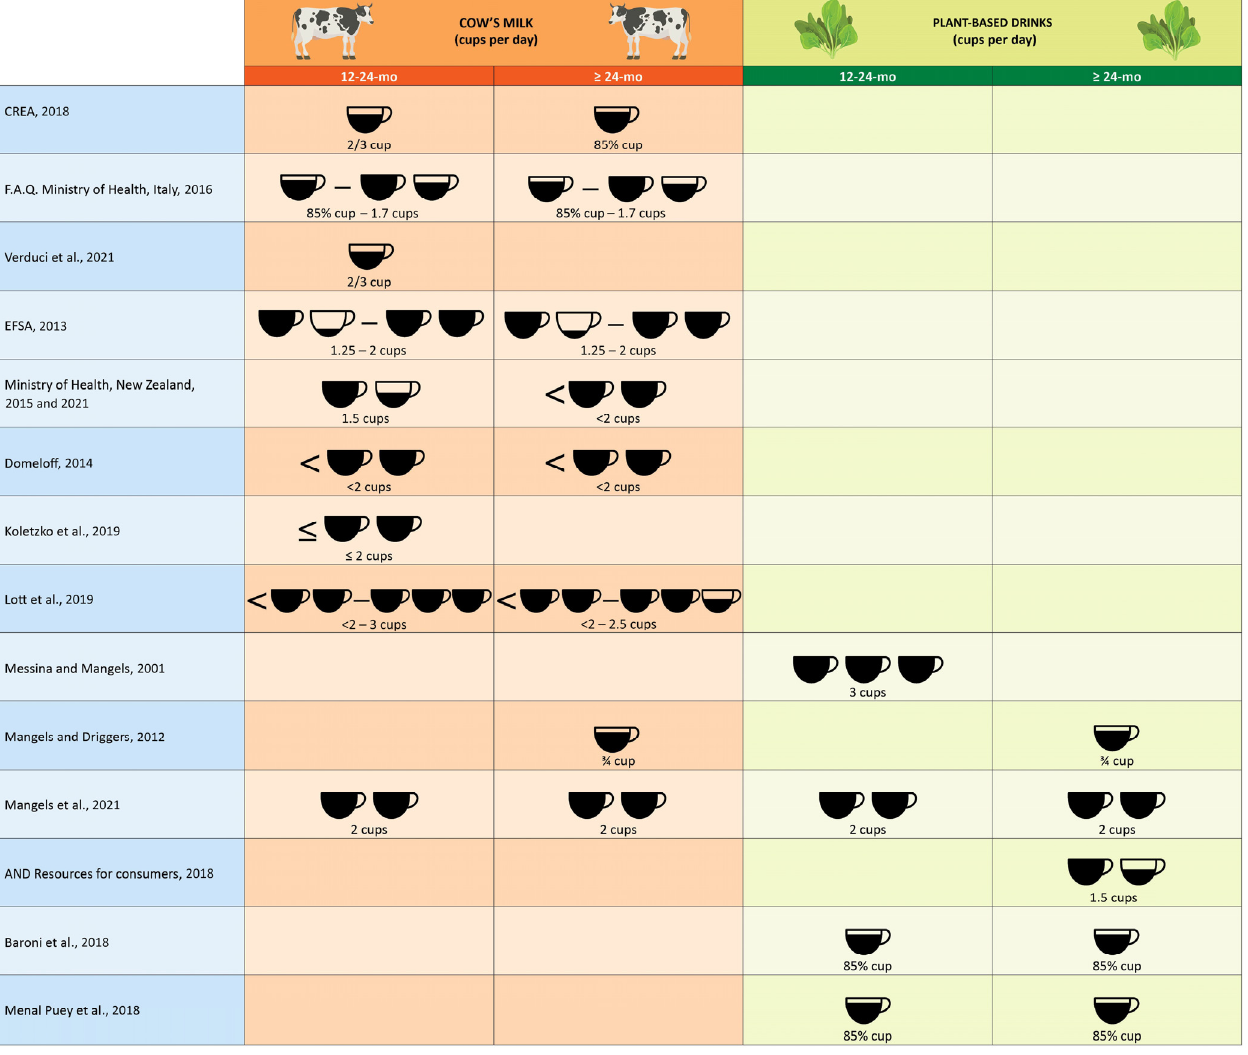
Table 4. Suggestions for the use of plant-based milk alternatives in specific situations starting from 1 year of age.